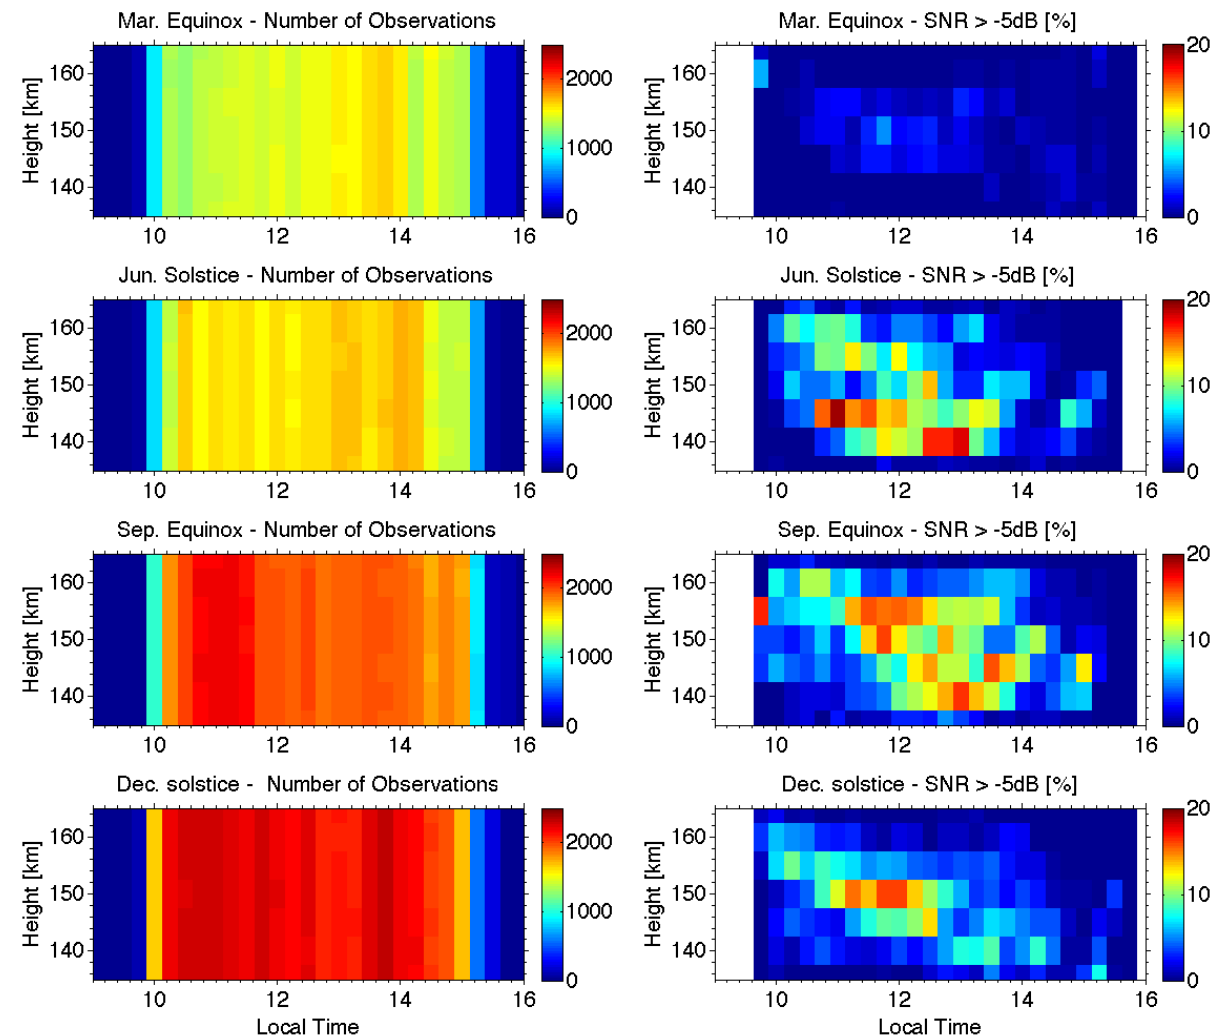
Fig. 6. Left-hand side panels show the number of observations versus height and local time for each season. Right-hand side panels show the occurrence rate of echoes with SNR greater than −